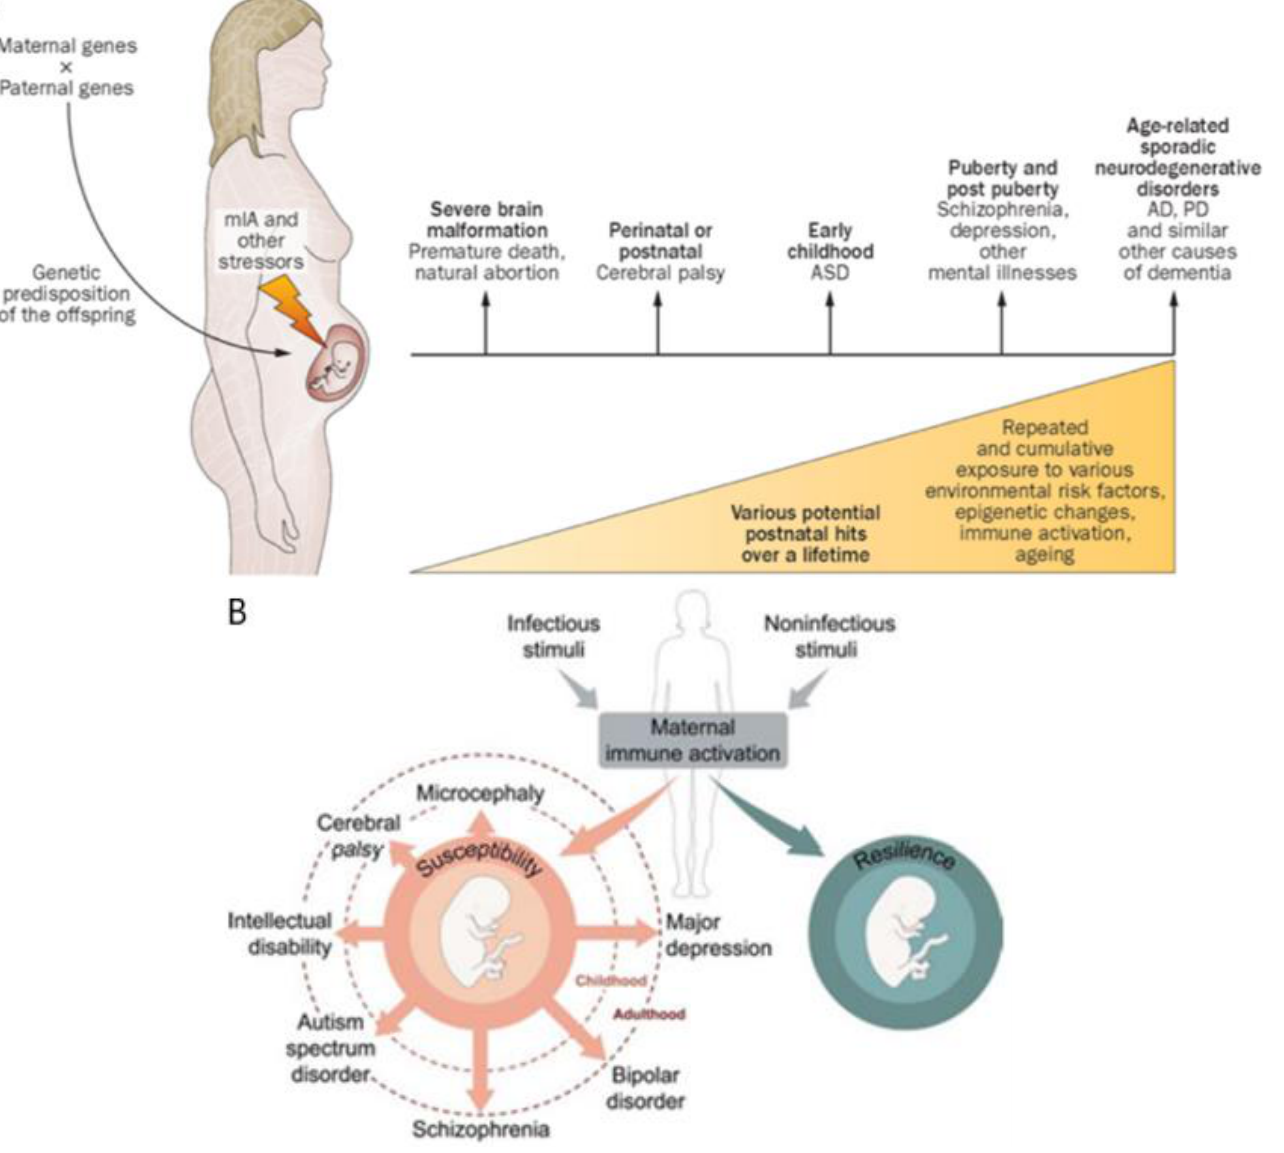
Figure 2. ( A ) Proposed causal chain of events with maternal immune activation in humans, leading to a wide spectrum of neuronal dysfunctions and behavioral phenotypes observable in the juvenile, adult, or aged progeny. Abbreviations: AD, Alzheimer disease; ASD, autism spectrum disorder; MIA, maternal immune activation; PD, Parkinson disease [19]. ( B ) Pathways for neurodevelopmental resilience and susceptibility to maternal immune activation are depicted, induced by infectious or noninfectious stimuli with variable effects on the offspring. Whereas a substantial portion of offspring are resilient to maternal immune activation and do not acquire overt pathologies, neurodevelopmental sequelae occur in susceptible offspring. The neurodevelopmental consequences among the latter are heterogeneous and span a range of neurological and psychiatric disorders with varying temporal onsets (as indicated by the corresponding lengths of the arrows and the broken-lined circles). Note that the illustrated pathways among susceptible offspring represent risks but not deterministic relationships [16].